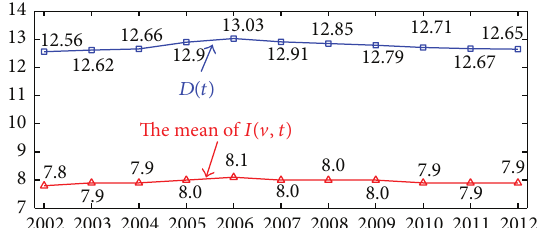
Figure 6: 𝐷(𝑡) and mean (𝐼( V ,𝑡)) curves from 2002 to 2012; (13) has better stability and can dynamically compute 𝐼( V , 𝑡) when V (𝑡) changes.